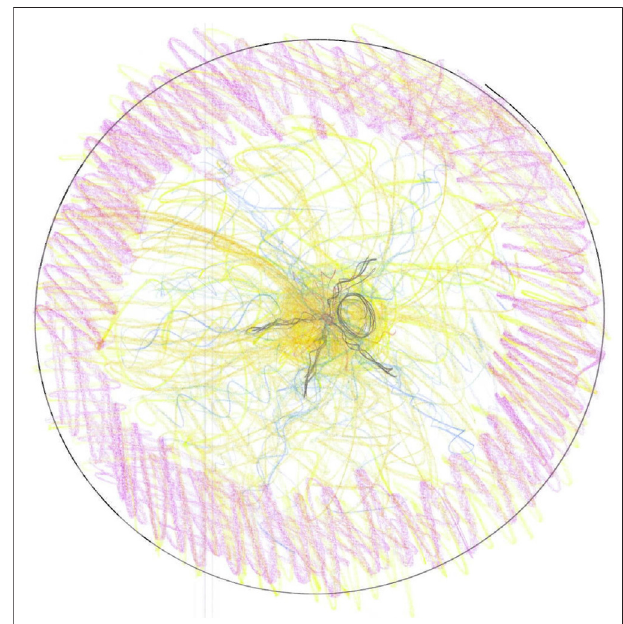
FIGURE 6 | I felt a sense of no longer being connected to my own body. The MRI scanner and I stepped into a different reality together. With colours, and shapes, and fi gures. Report 32, female, CME, MEQ total 4.7.